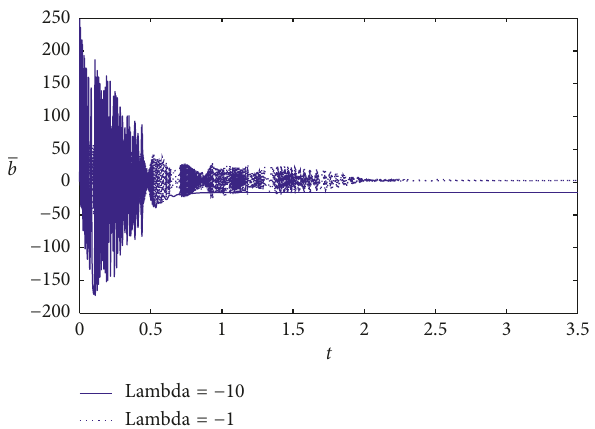
Figure 5: The time response of state b of system (29) with , x ,x x 1 ( 0 ) (cid:26) 5 2 ( 0 ) (cid:26) 0 3 ( 0 ) (cid:26) − 4.